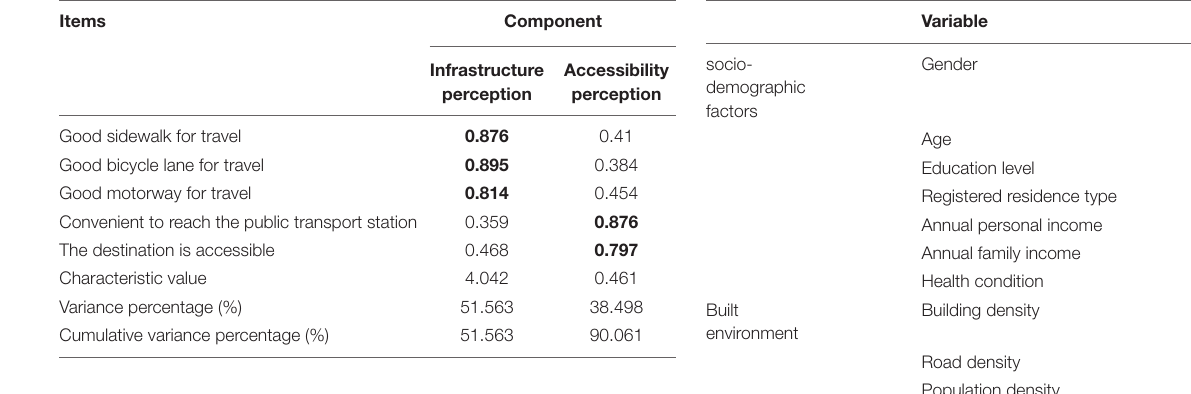
TABLE 5 | Built environment perception: composition matrix after rotation.